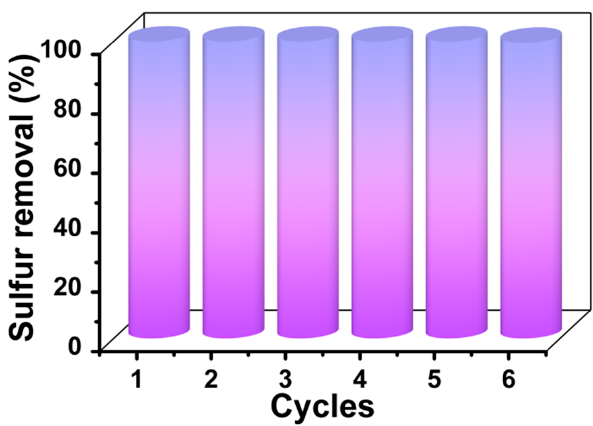
Figure 13. E ff ect of recycle runs of [BMIM] 3 PMo 12 O 40 -based MCF on sulfur removal e ffi ciency. Ex- perimental conditions: T = 60 °C, V DBT = 5 mL, V IL = 3 mL, O/S = 6, m([BMIM] 3 PMo 12 O 40 -based MCF) = 30 mg, and t = 3 h.